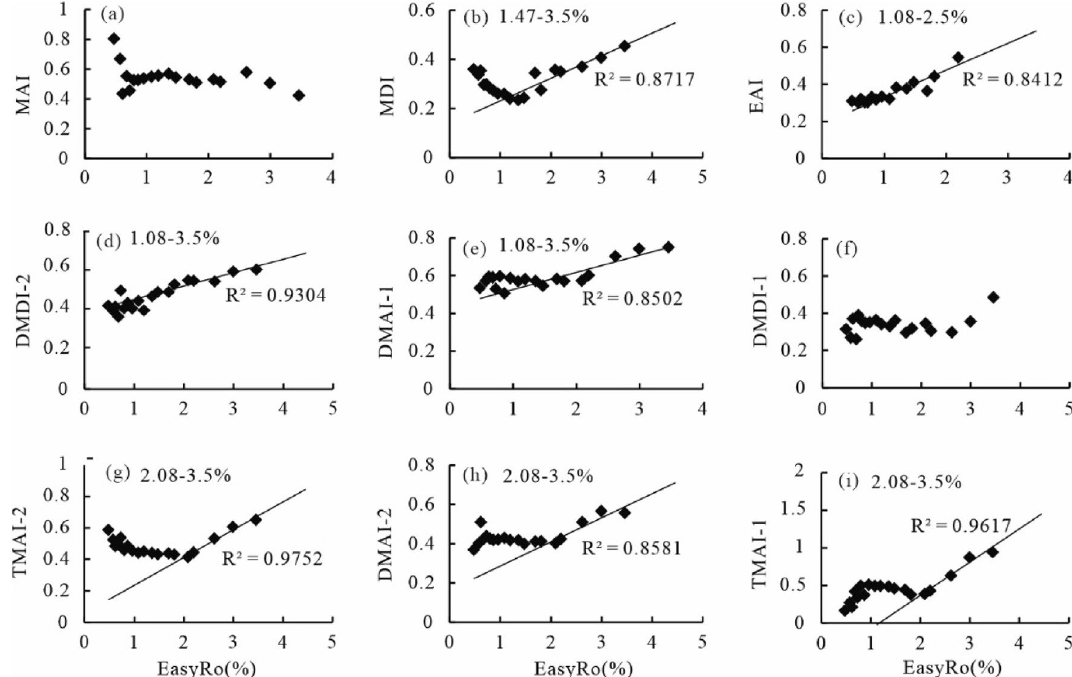
Figure 7. Plots showing the variation of diamondoid indices (MAI, MDI, DMAI-1, DMAI-2, DMDI-1, EAI, TMAI-1 and TMAI-2) with EasyRo (%) from anhydrous and hydrothermal pyrolysis of oil. MAI = 1-MA/ (1-MA + 2-MA), MDI = 4-MD/(4-MD + 1-MD + 3-MD), DMAI-1 = 1,3-DMA/(1,2-DMA + 1,3-DMA), DMAI-2 = 1,3-DMA/(1,2-DMA + 1,4-DMA), DMDI-1 = 3,4-DMD/(4,9-DMD + 3,4-DMD), DMDI-2 = 4,8- DMD/(4,9-DMD + 4,8-DMD), EAI = 2-EA/(1-EA + 2-EA), TMAI-1 = 1,3,5-TMA/(1,3,5-TMA + 1,3,4-TMA), TMAI-2 = 1,3,5-TMA/(1,3,5-TMA +